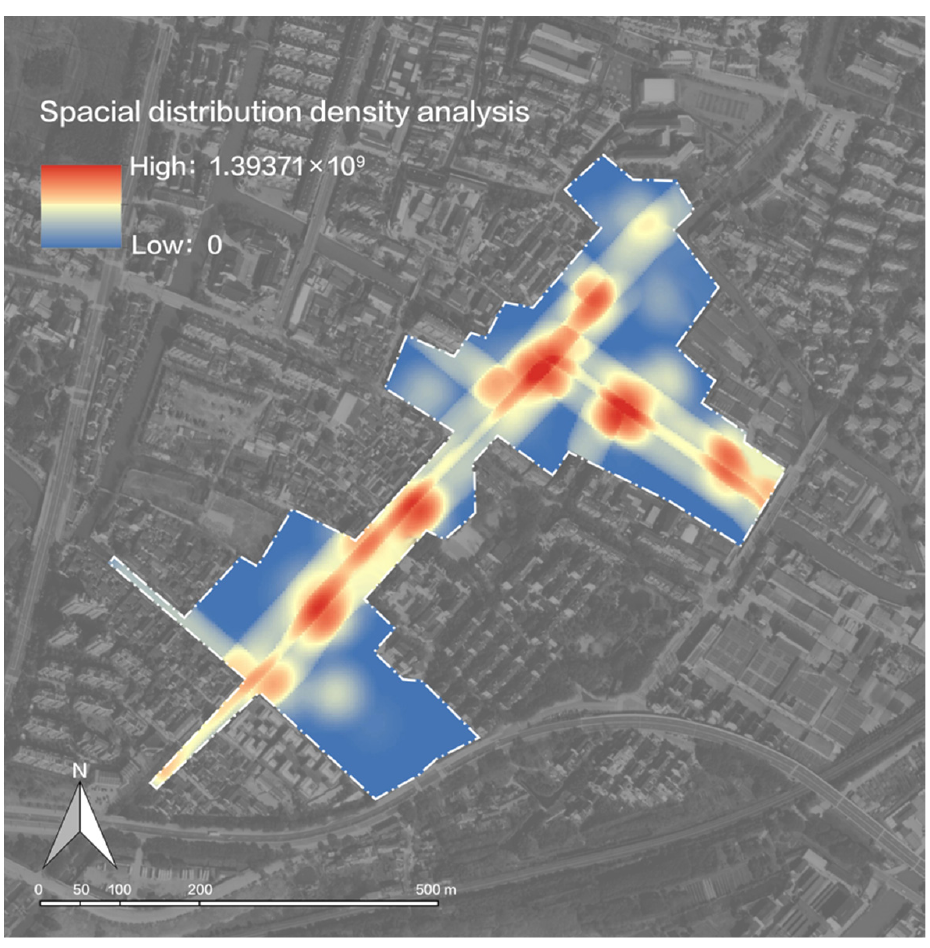
Figure 11. The Kernel density analysis of the distribution of space in travel photos (source: authors).